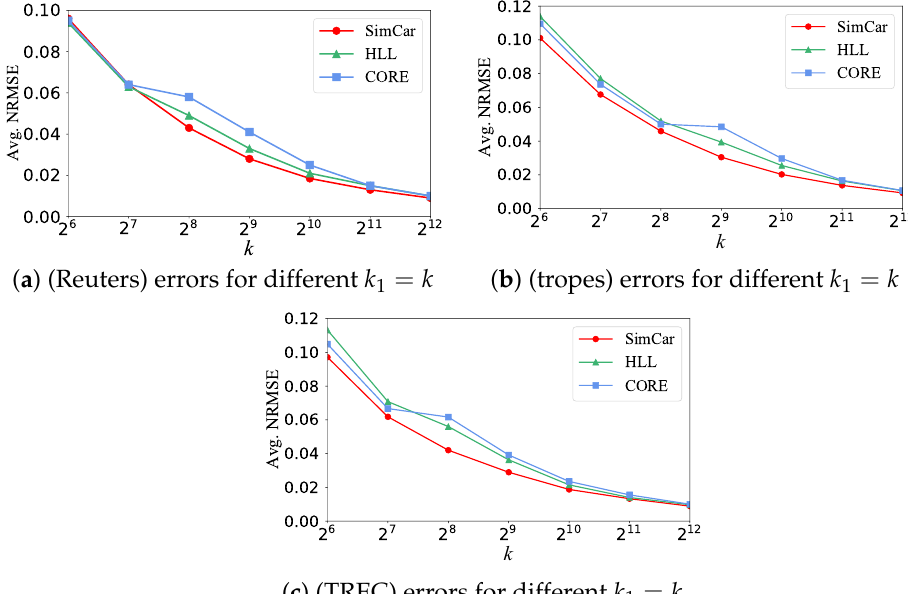
Figure 4. User cardinality estimation errors of our framework, SimCar, compared with HLL and CORE, k 1 = k = 2 9 by